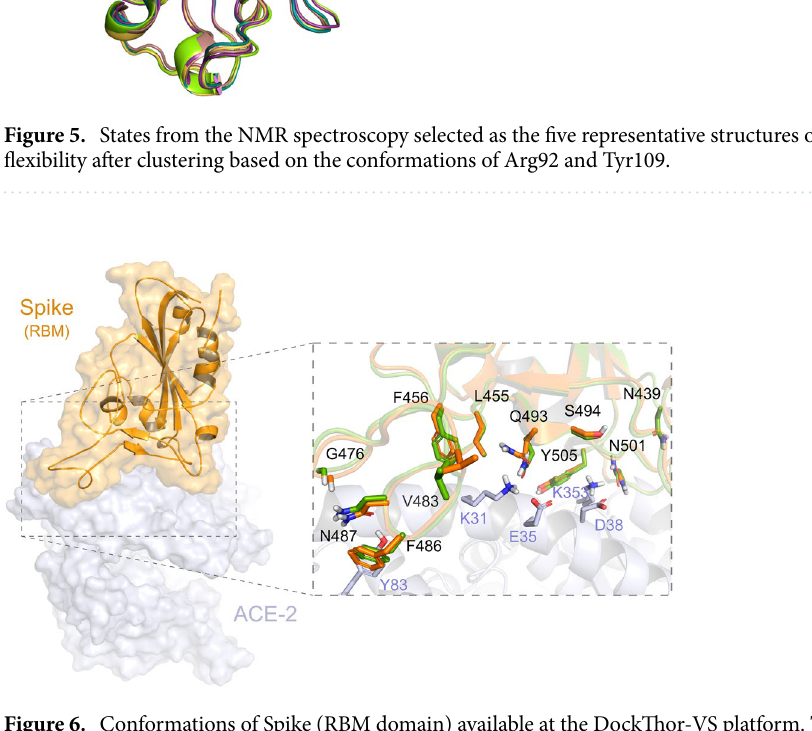
Figure 6. Conformations of Spike (RBM domain) available at the DockThor-VS platform. The human receptor ACE2 is coloured grey. The Spike-ACE2 interface is illustrated with zoom. The two Spike conformations (PDB codes 6M0J and 7BZ5) are coloured orange and green,